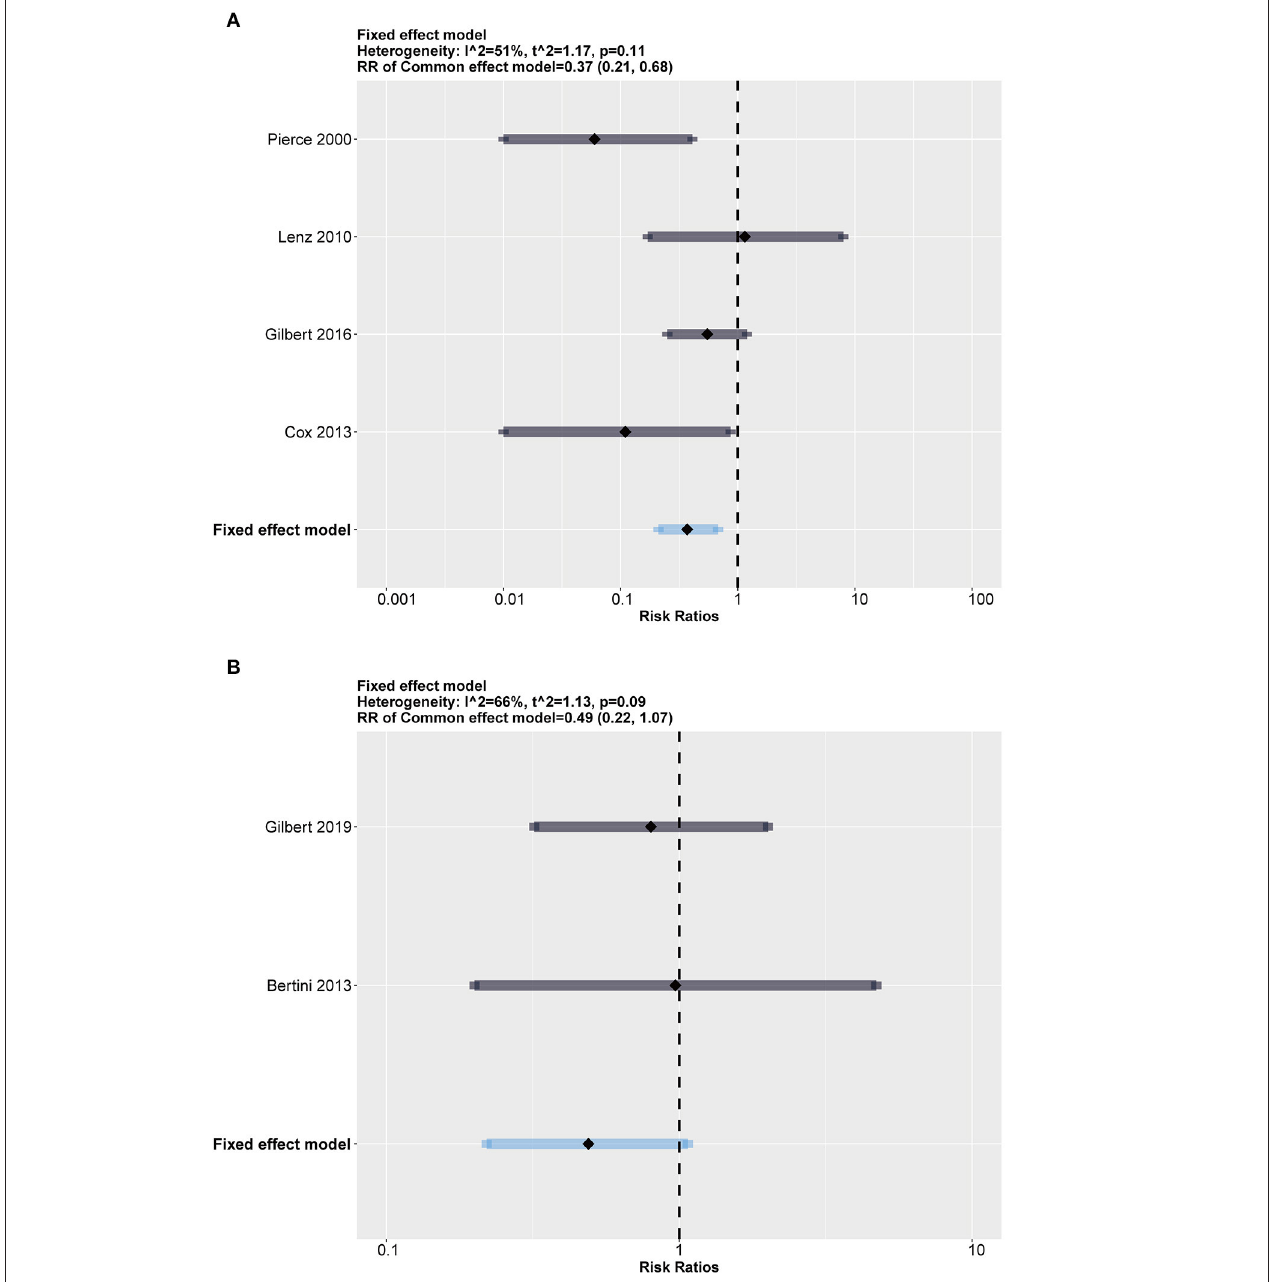
FIGURE 5 | Subgroup analysis between neonates (age ≤ 28 days) and children (28 days < age ≤ 18 years). Both groups show high heterogeneity. (A) Forest plot in children (28 days < age ≤ 18 years) group (compared with standard). (B) Forest plot in neonates (age ≤ 28 days) group (compared with